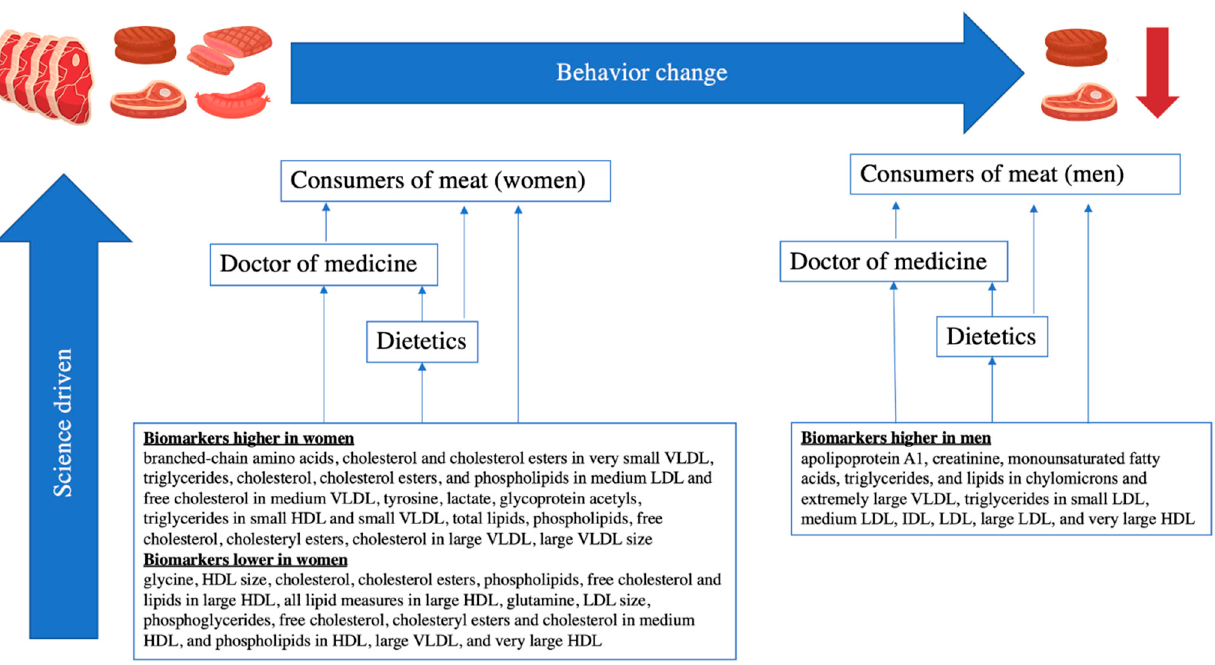
Figure 3. A simple model comprising the key findings of this study, consumers of meat (men and women), doctors of medicine, and dietetics to demonstrate science-based health education strategy.